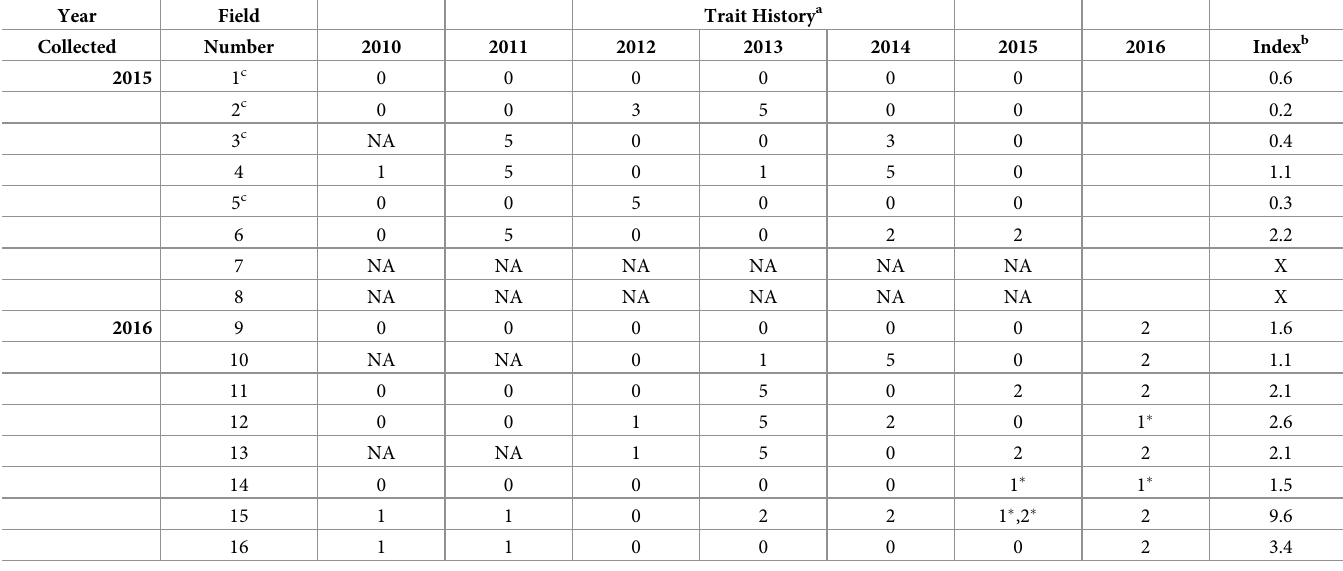
Table 3. Yearly trait history and cumulative index value of Buffalo County